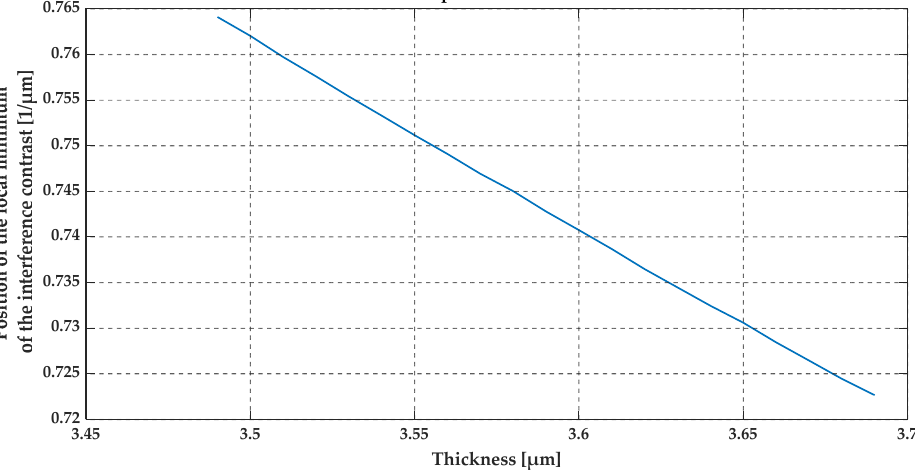
Figure 11. The relationship between the location of the minimum value of the interference contrast and the layer thickness of glass foil.